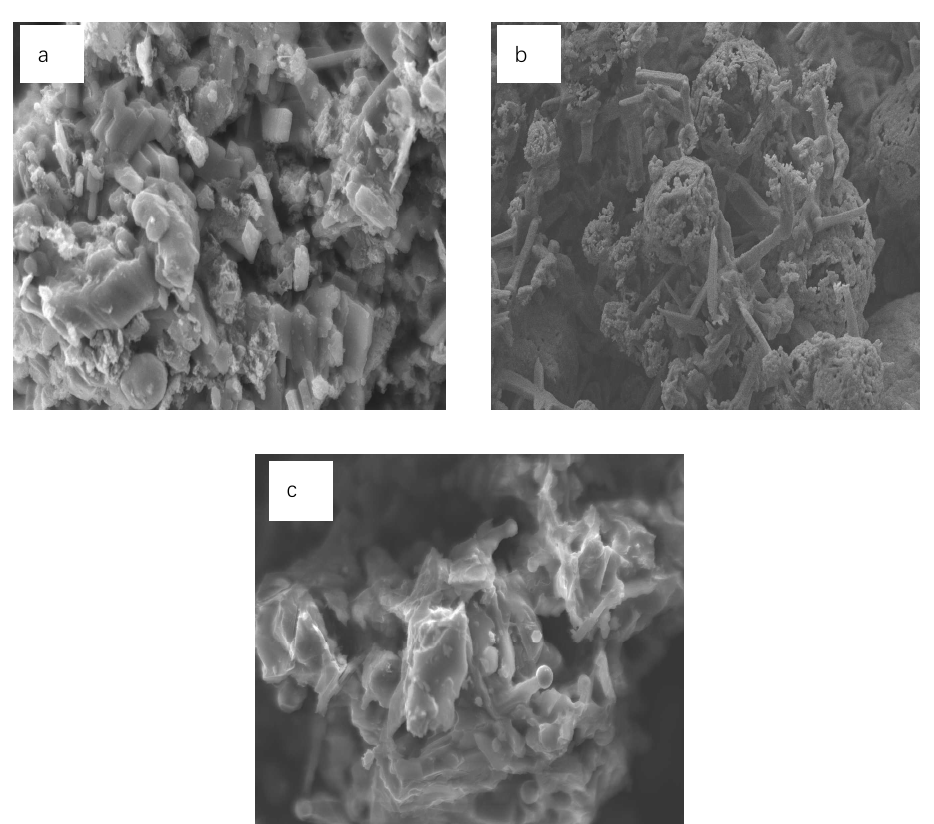
Figure 6. SEM images of the nitridation products prepared from TE ( a ), HT ( b ) and SH ( c ) at 1450 °C for 4 h.